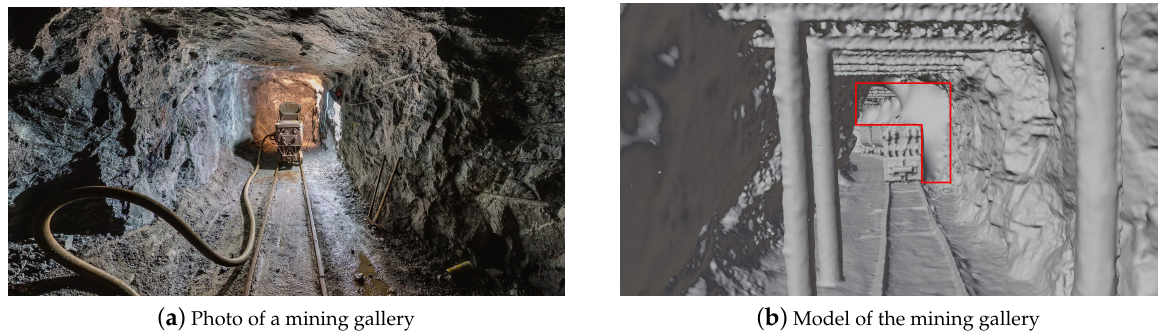
Figure 17. ( a ) The photo shows a gallery of the mine Reiche Zeiche in Freiberg. Graphic after [78]. ( b ) The photo shows a polygonal 3D model of the gallery Wilhelm-Stehender-Süd in the mine Reiche Zeche in Freiberg in which a virtual depth sensor was simulated. The red area marks a region where additional polygons were added to close holes present in the initial photogrammetric model.